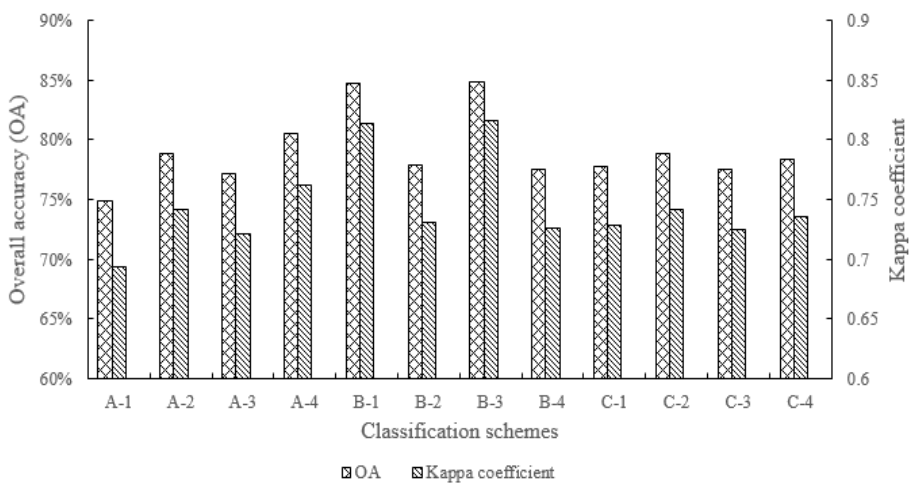
Figure 6. Overall classification accuracy and kappa coefficient of all different classification schemes. Table 7. Classification accuracy statistics of red edge spectral features.